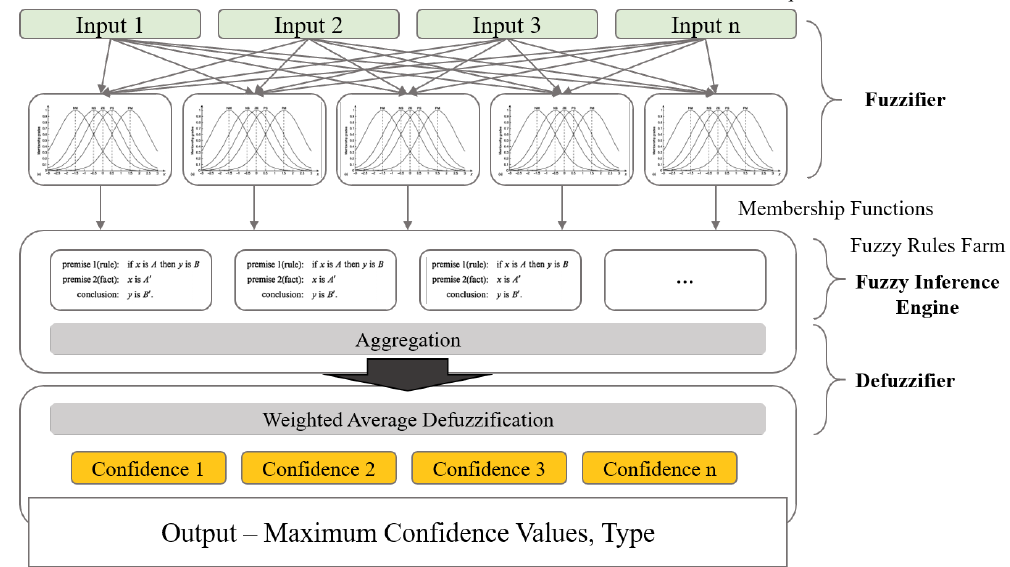
Figure 9. It is a schematic diagram of Algorithm 2. It shows processes that the membership level of the input traffic data is measured for the fuzzy set and membership function that exist for each criterion, and the membership level values of each feature are aggregated and determined through the weighted average defuzzification method. The results are expressed as confidence, which indicates similarity to the type of traffic in question.